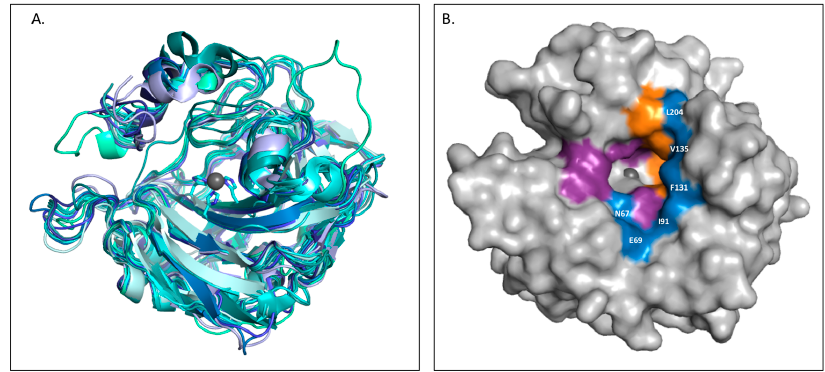
Figure 1. ( A ) Overlay of catalytically active human Carbonic anhydrase (CA) isoforms; ( B ) Surface representation of CA II with hydrophobic and hydrophilic regions colored orange and purple, respectively. Isoform-unique residues within the active site are colored blue and labeled.